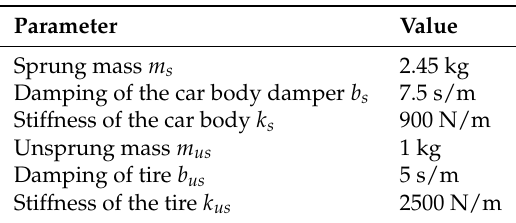
Table 1. Nominal model